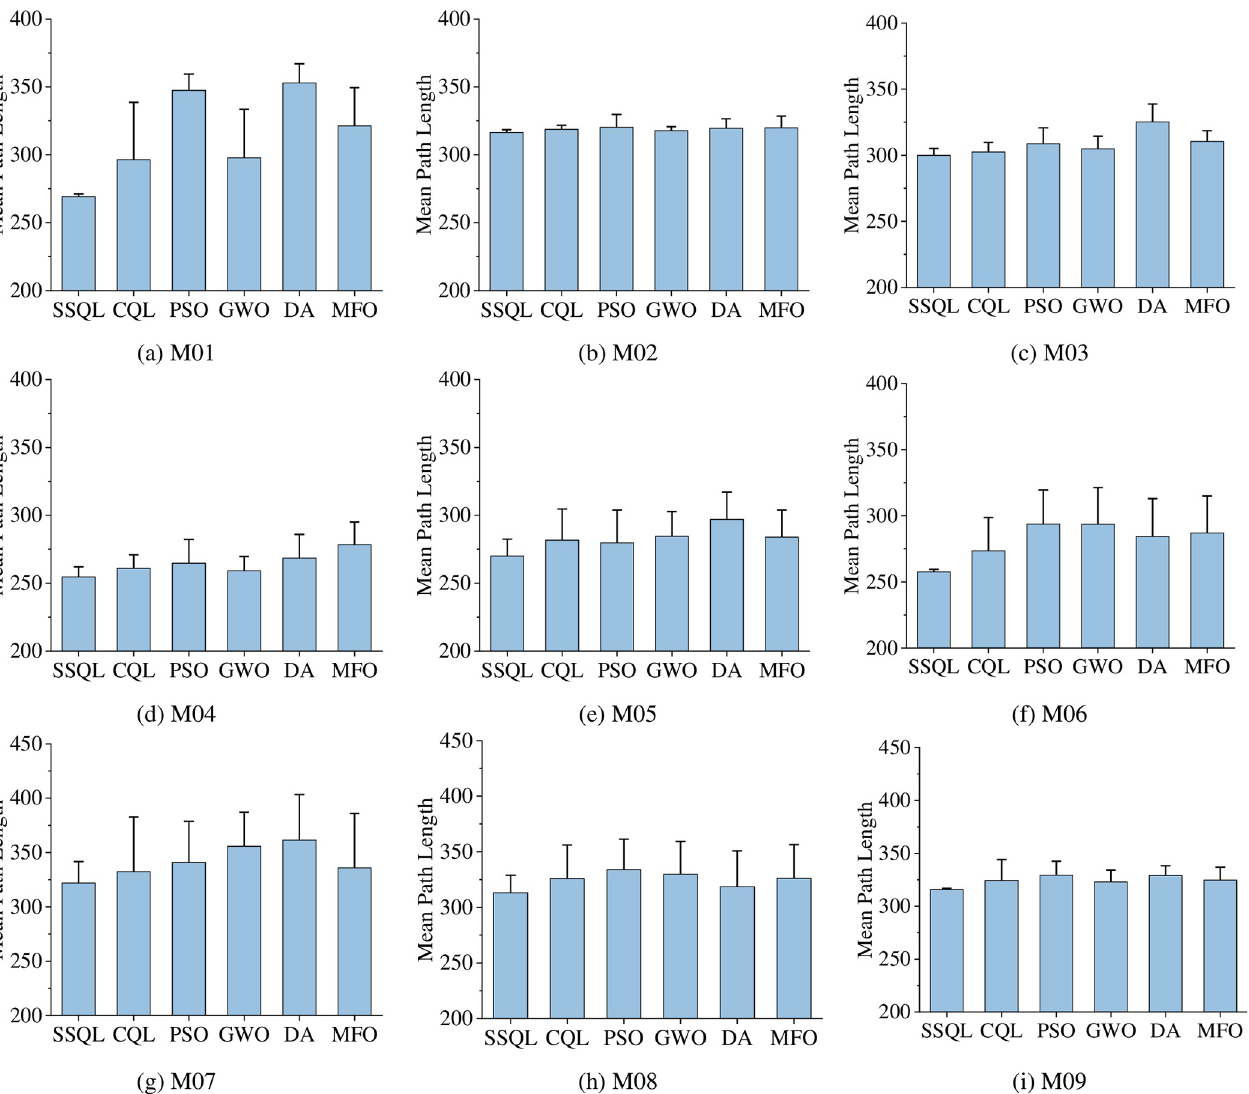
Fig 6. Compared mean path length of various path planning algorithms for MR (The interval on each bar denotes the standard deviation of the path length).